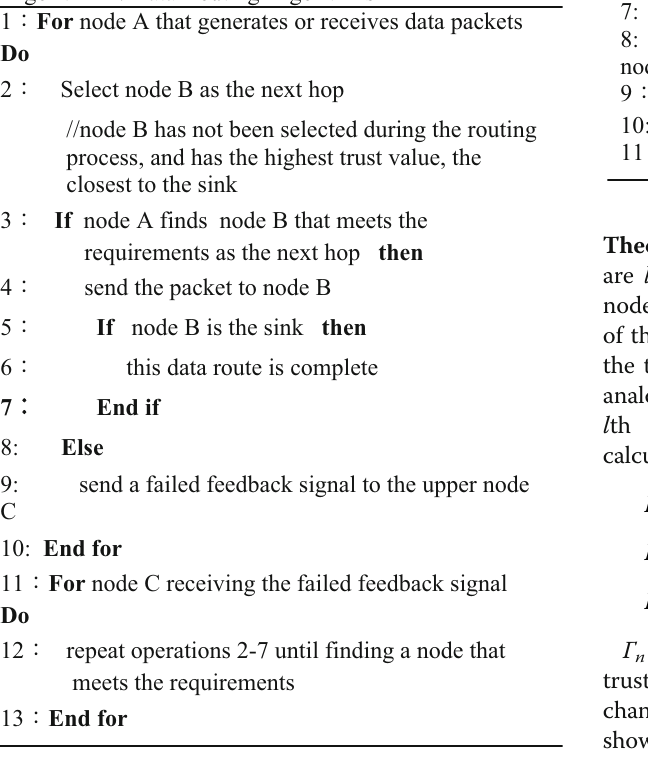
Algorithm2 : Data Routing Algorithms